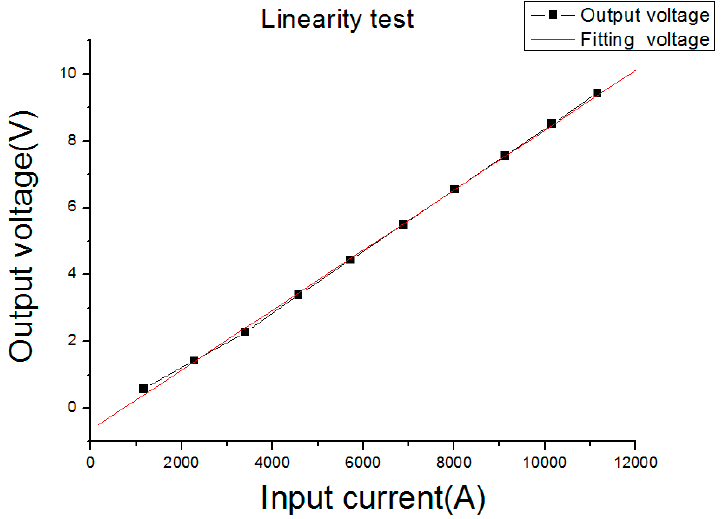
Figure 12. Linearity test fitting curve.